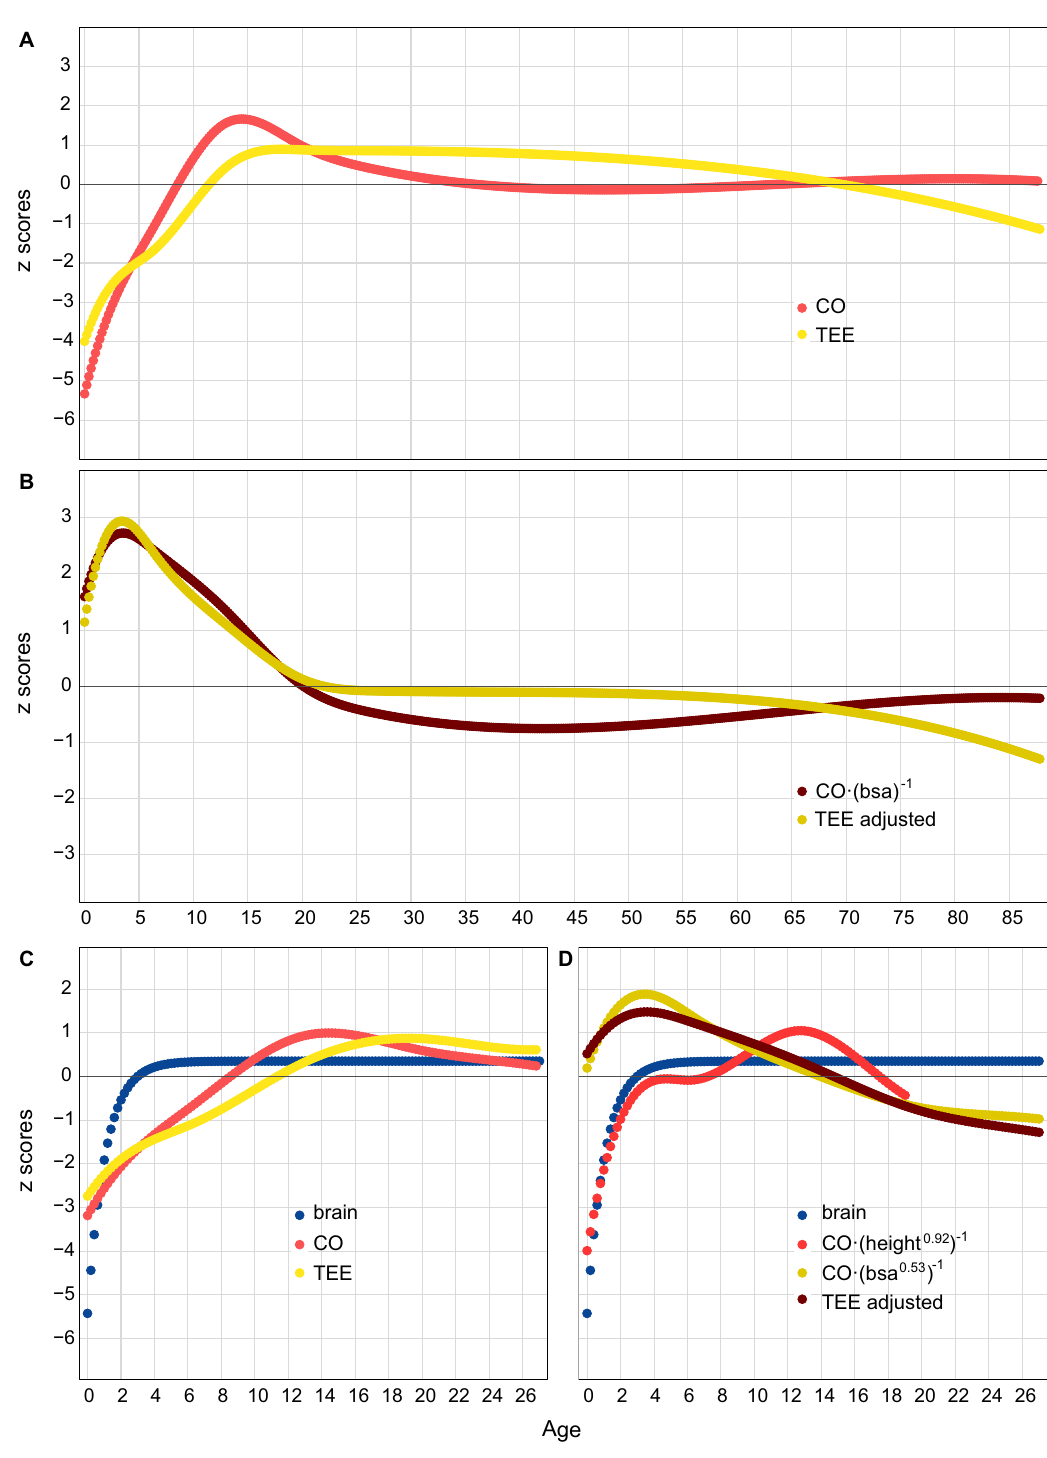
Figure 3. Change along the lifespan of cardiac output (CO), and total energy expenditure (TEE) ( A ), and of both variables adjusted to body surface area (CO/bsa) 13 and fat free mass 3 , respectively ( B ). Change between birth and adulthood of brain weight, cardiac output, and total energy expenditure ( C ). In ( D ), the same variables, but with cardiac output scaled to height and body surface area 14 , and TEE adjusted to fat free mass 3 ( B ). Data were first obtained from the literature (Supplementary Material 7), and then a Gompertz (brain), or cubic spine function (all the other variables), were fitted to the values. Predicted values from the functions were obtained and converted to z-scores for comparison between variables (Supplementary Material